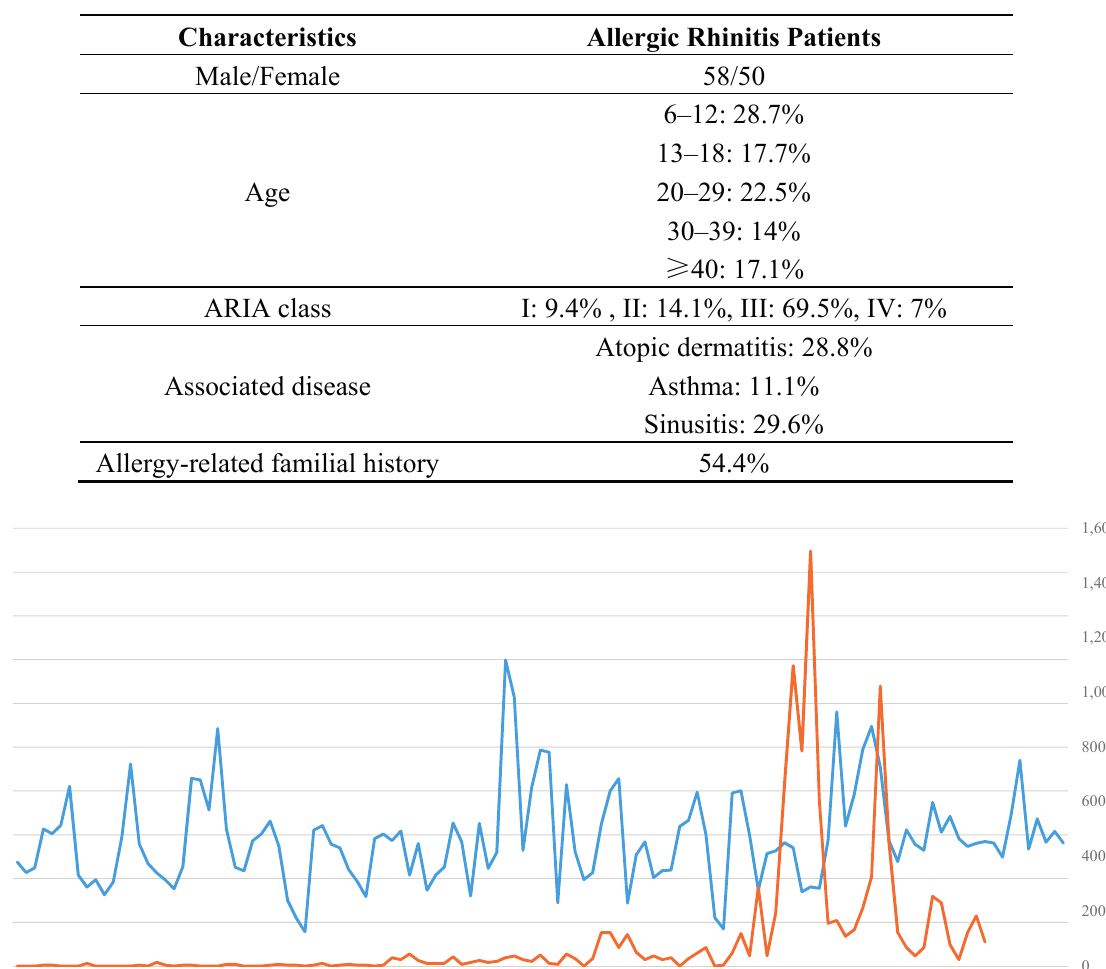
Table 2. Patient characteristics.